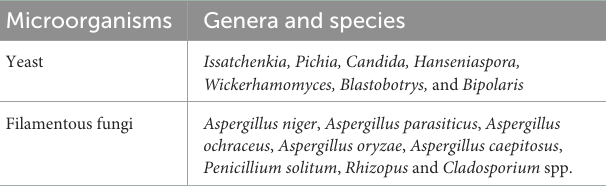
TABLE 4 Genera and species of microorganisms identified in the composting process in both treatments during the composting process.